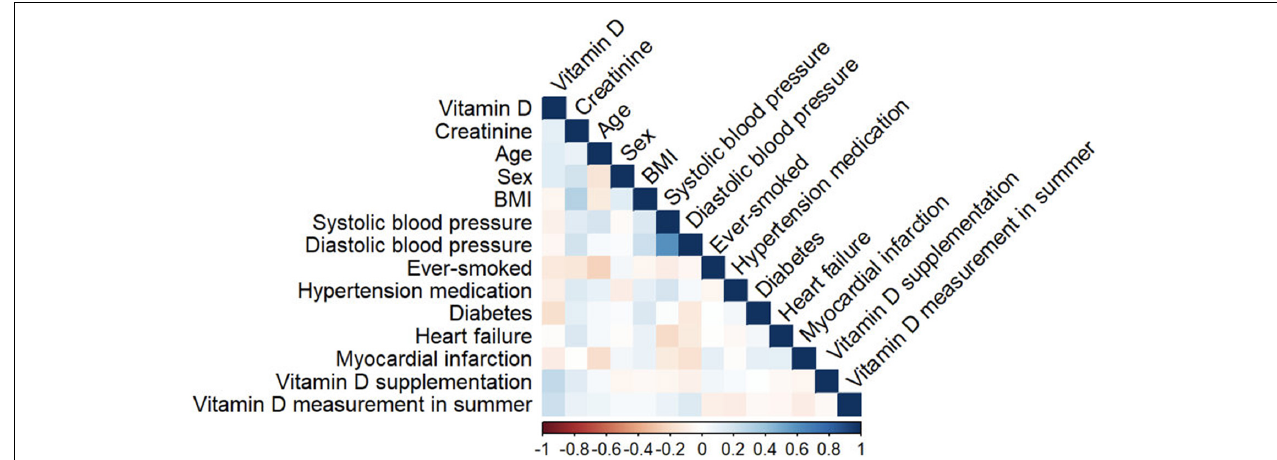
FIGURE 1 | Heat map of correlations of biomarkers and covariates. The colour-coded scale is shown below.